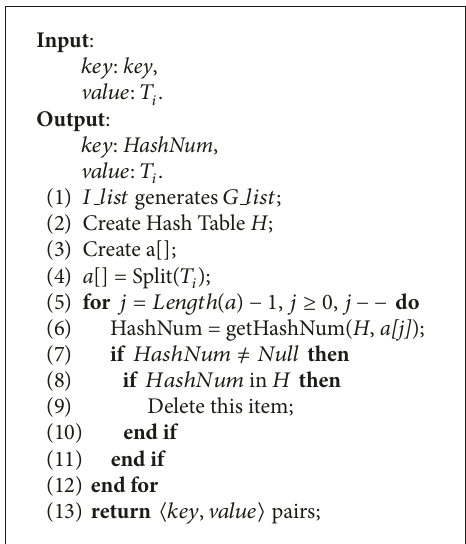
Algorithm 6: Reduce( 𝑘𝑒𝑦 , V 𝑎𝑙𝑢𝑒